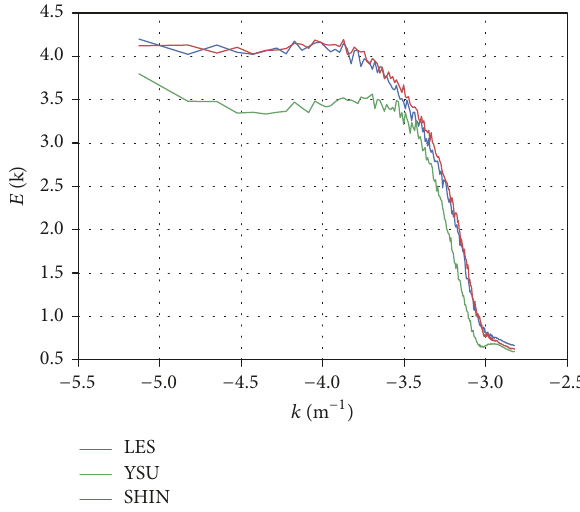
Figure 10: Power spectra of 𝑤 at 3000 m simulated on the d04 at 1400 BJT, 1 July